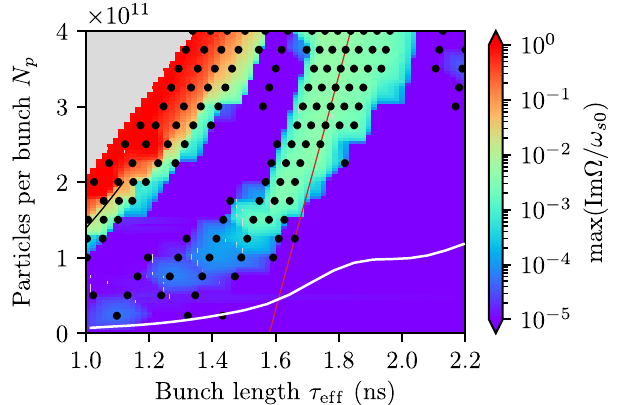
FIG. 3. Longitudinal stability map obtained from calculations with code MELODY (bottom) for the same parameters as in Fig 2. The color code shows the growth rate of the most unstable mode, while the gray area indicates parameters for which stationary distribution was not found. The bunch parameters for which synchrotron frequency is a nonmonotonic function of E are shown as black circles. The black and red lines show examples of the bunch-length dependence on intensity due to PWD for ¼ 0 . 12 and constant energy of synchrotron oscillations E max E ¼ 0 . 57 , respectively. The solid white curve corresponds max to the LLD threshold computed with MELODY